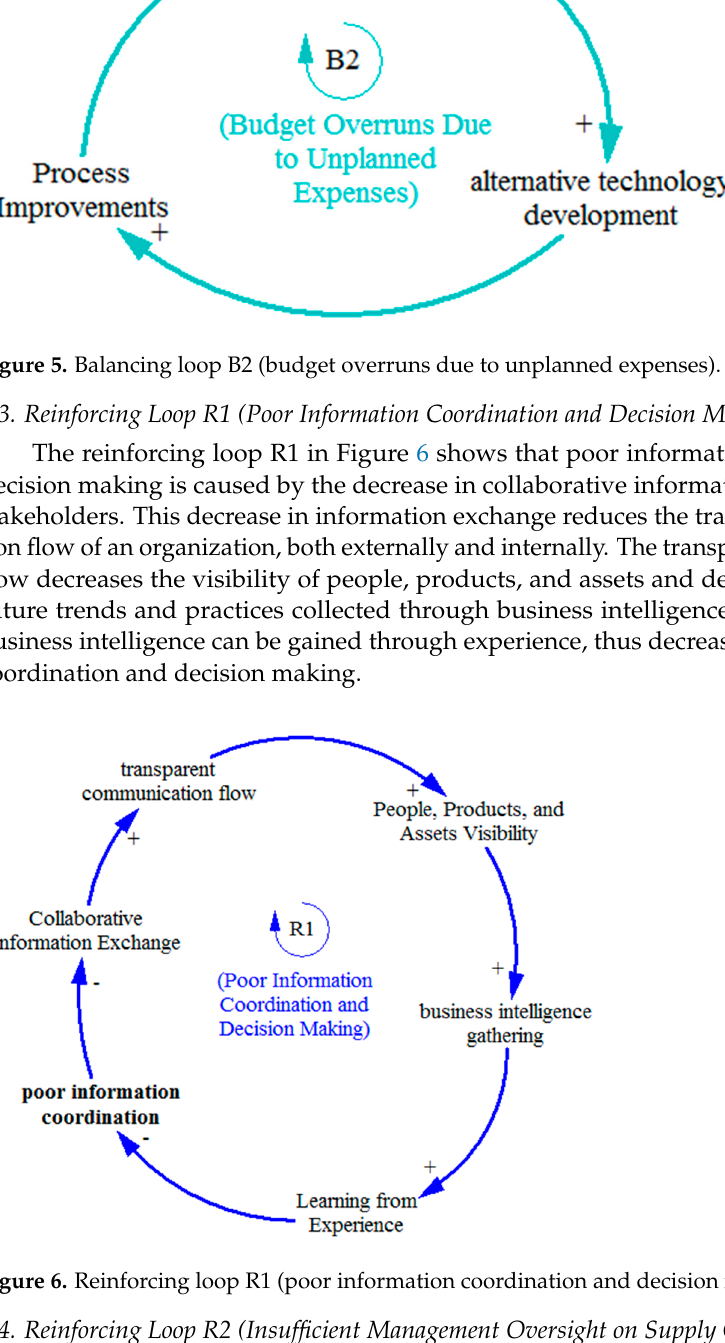
15 of 27 Figure 4. Balancing loop B1 (health pandemic affecting employees). 4.2. Balancing Loop B2 (Budget Overruns Due to Unplanned Expenses) The balancing loop B2 in Figure 5 indicates that the increase in budget overruns due to unplanned expenses leads to an increase in alternative technology development by an